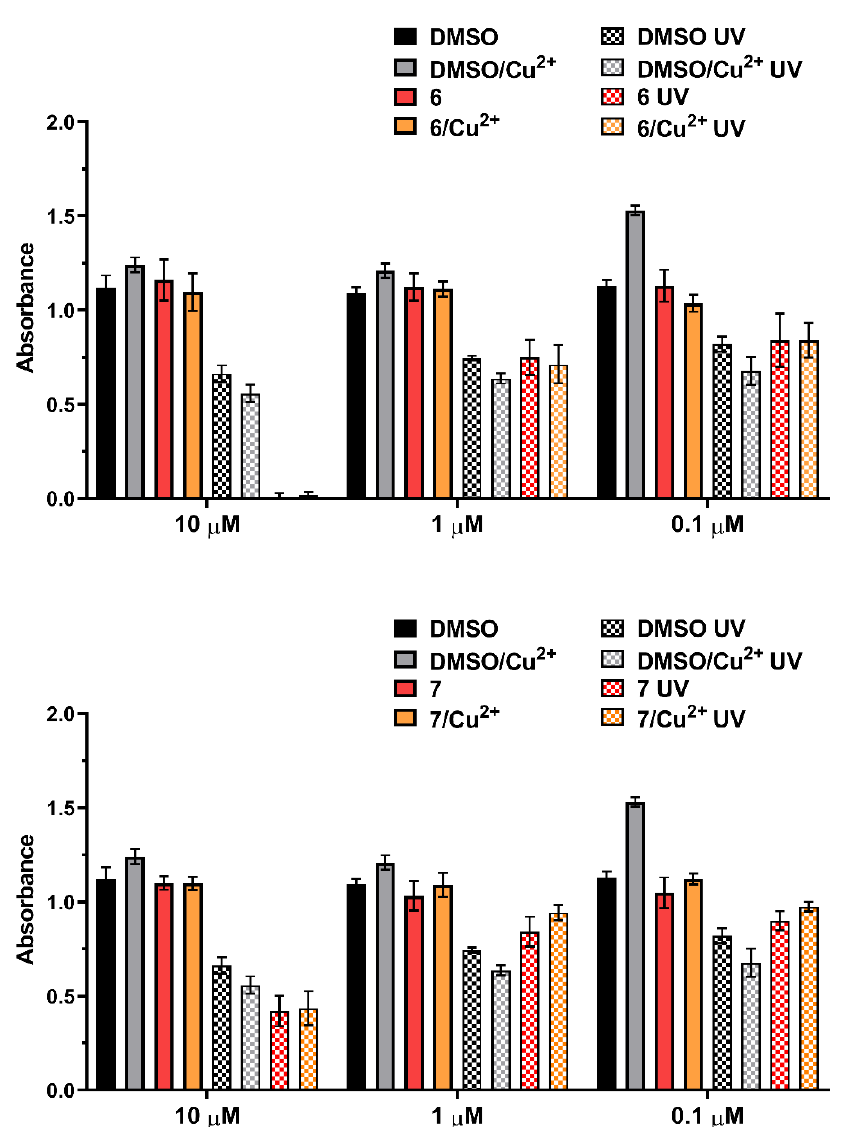
Figure 8. Cell survival of A549 cells treated with different concentrations of 6, 6/Cu complex, 7 and 7/Cu complex with or without UV light irradiation (350 nm) for 30 min. Measured absorbance ( λ = 600 nm) directly correlates with cell survival. Data are presented as mean ± SD made in three replicates. Control samples are cells treated with DMSO in the same dilution as a tested compound. Representative data of two independent experiments which yielded similar results are